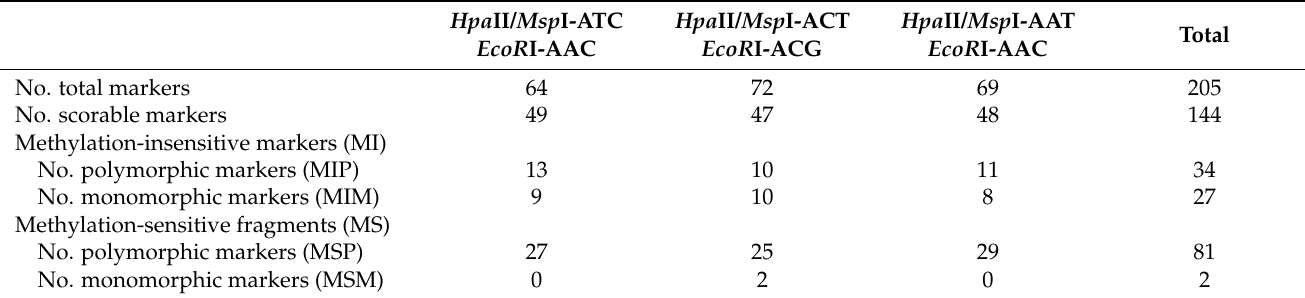
Table 2. Number of MSAPs detected with the primer combinations used to analyze the seedlings from Spanish, German and Swedish Fagus sylvatica